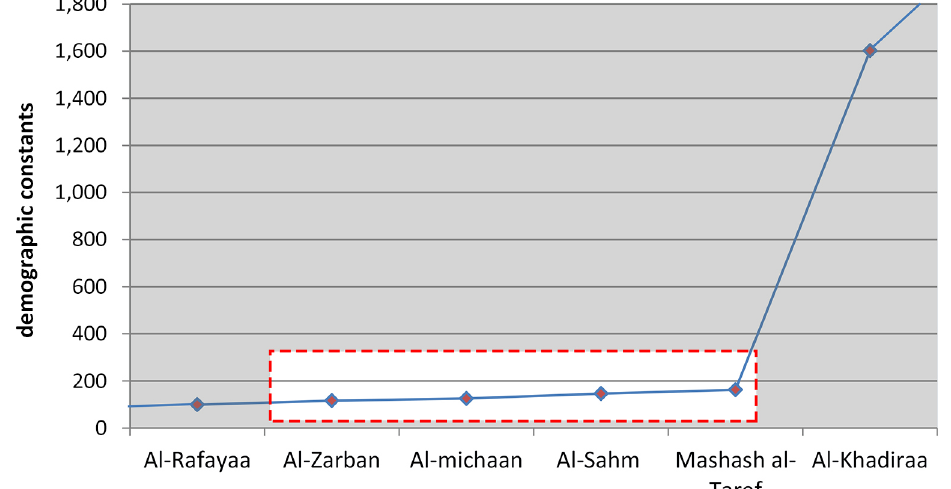
Fig. 8. Zoom shot of level 6 of the